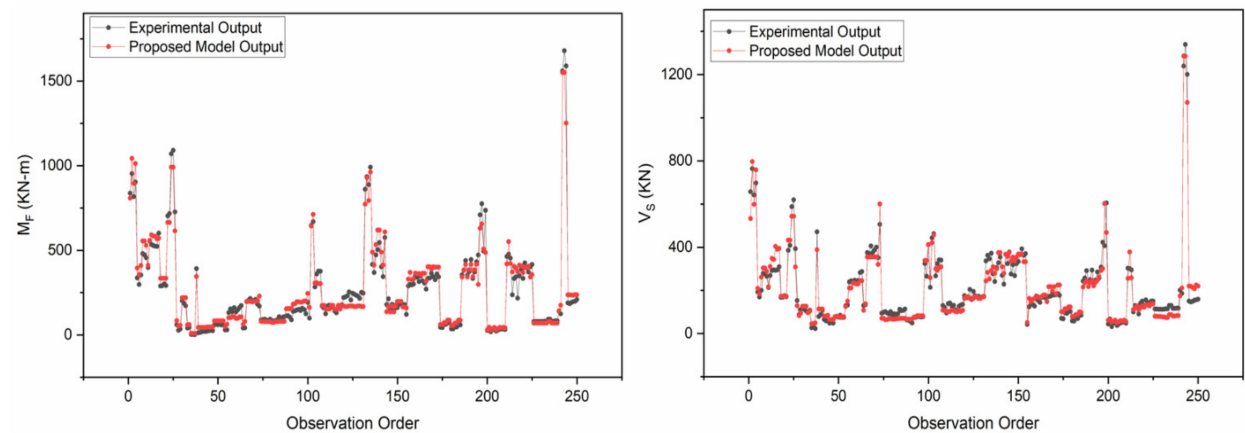
Figure 8. Comparison of Experimental and Proposed Model Results.